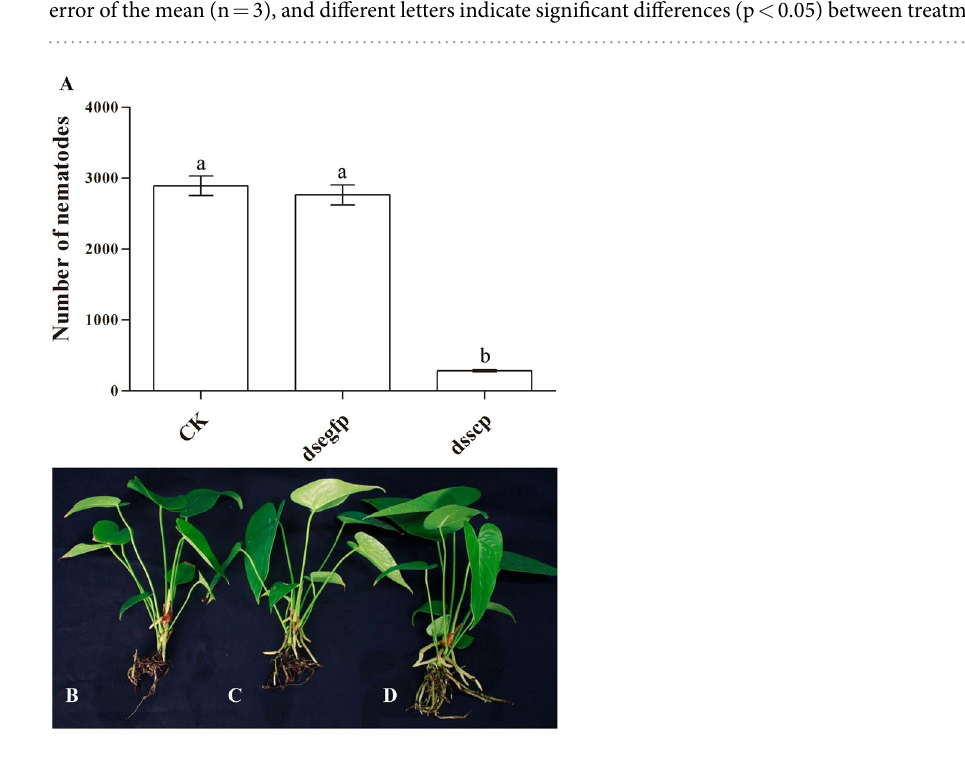
Figure 7. Effects of Rs - scp - 1 RNAi on the reproduction and pathogenicity of Radopholus similis . ( A ) Number of R . similis in anthurium roots. CK: untreated nematodes; dsegfp: nematodes treated with egfp dsRNA for 12 h; dsscp: nematodes treated with Rs - scp - 1 dsRNA for 12 h. Bars indicate the standard error of the mean (n = 5), and different letters indicate significant differences (p < 0.05) between treatments. ( B ) Anthurium inoculated with untreated nematode. ( C ) Anthurium inoculated with nematodes treated with egfp dsRNA for 12 h. ( D ) Anthurium inoculated with nematodes treated with Rs - scp - 1 dsRNA for 12